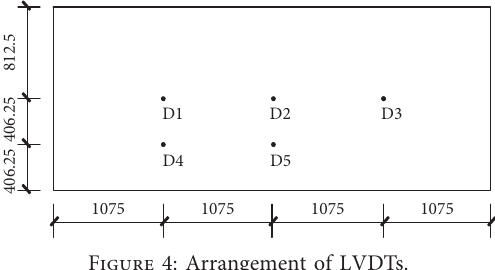
Figure 4: Arrangement of